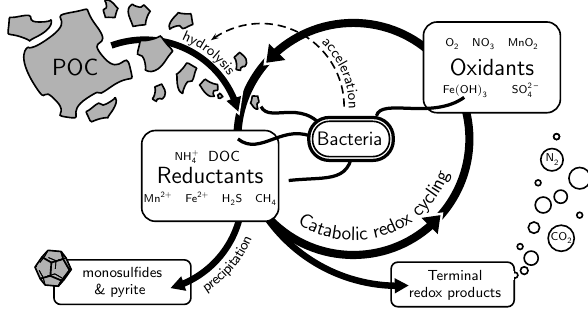
Fig. 3. Sketch of the biochemical cycling scheme in each ISM model box: functional groups of heterotrophic and lithotrophic bac- teria conduct the irreversible redox reactions. Educts may partici- pate in subsequent redox reactions. Heterotrophic bacteria acceler- ate POC hydrolysis.